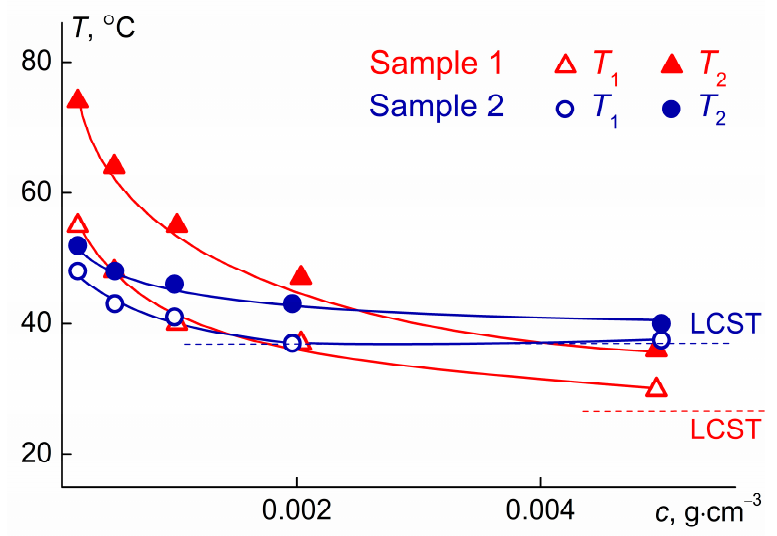
Figure 11. Concentration dependences of the temperatures T 1 and T 2 for solutions of investigated brushes.